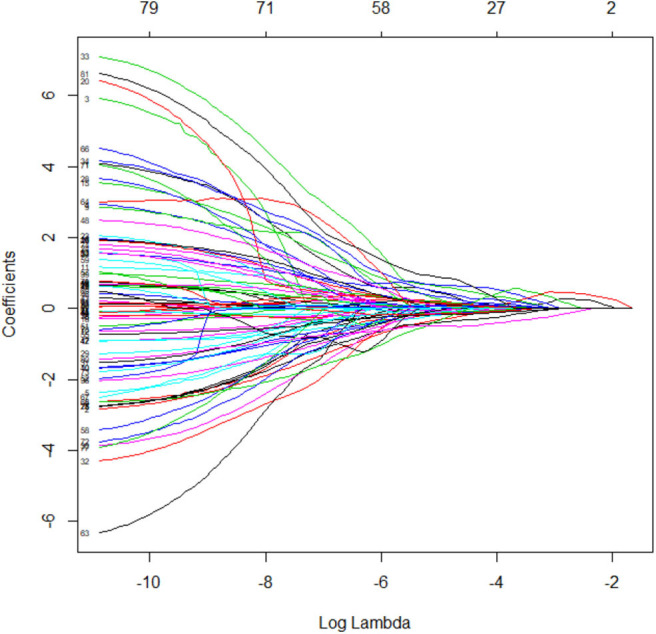
The LASSO coefficient profiles of radiomics signature.